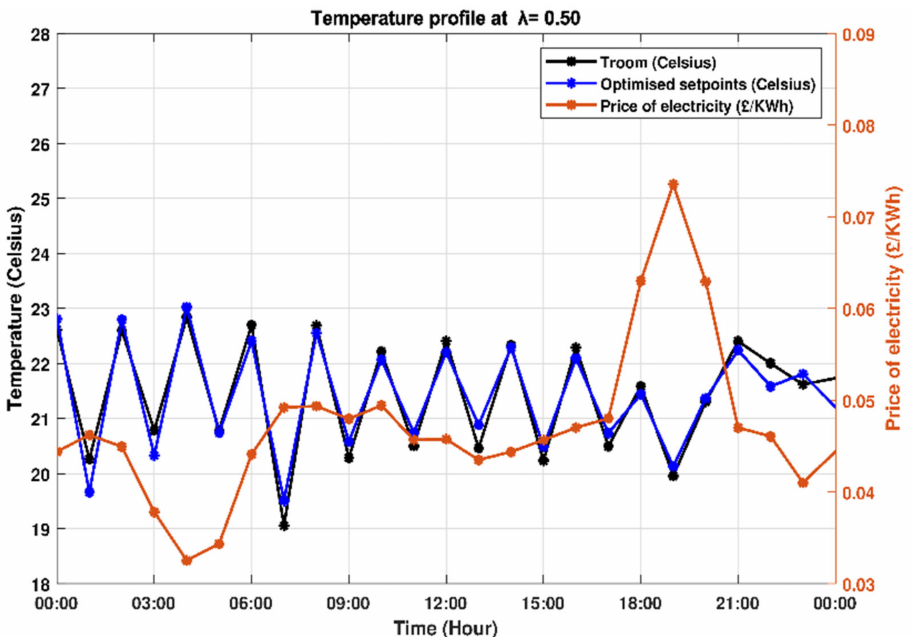
Figure 6. Room temperature and MPC-generated setpoints over 24 h when λ is set to 0.5—indicating balanced preference for energy saving and thermal comfort.